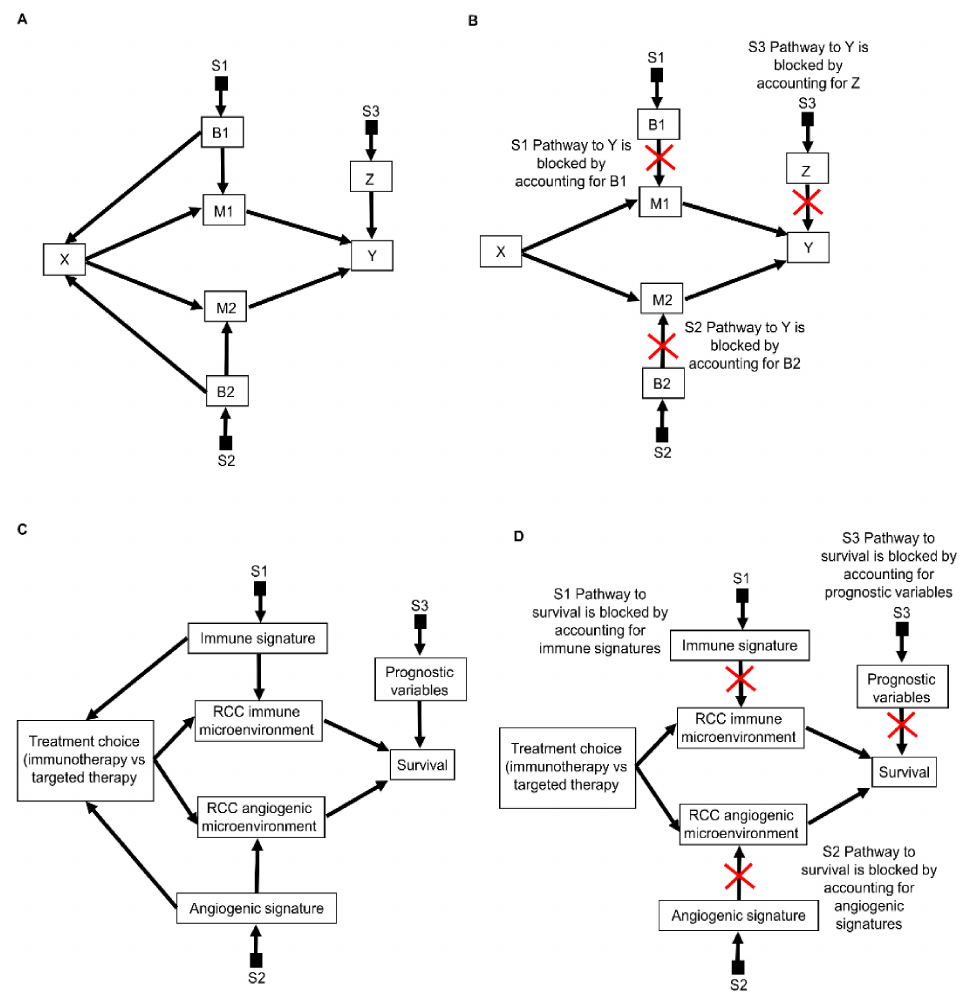
Figure 9. Selection diagrams representing more complex scenarios of treatment effect heterogeneity: ( A ) The effect of treatment choice X on the outcome Y is mediated by two mediators, M1 and M2, which are influenced by biomarkers B1 and B2, respectively. Prognostic variables Z also independently influence the outcome Y. B1 and B2 also influence the treatment choice X. Patient populations may differ in B1 (denoted by S1), B2 (denoted by S2) and in Z (denoted by S3); ( B ) The same selection diagram modified to illustrate the considerations behind the S-admissibility criterion licensing the transportation of knowledge toward the population of patients seen in the clinic. S-admissibility states that once all arrows pointing to the treatment variable X are removed, we need to covariate weight for all variables needed to block all causal pathways that transmit effects from each selection node S toward the outcome Y. In this example, covariate weighting for B1, B2, and Z, respectively, blocks the pathways (as indicated by the red crossmarks) from S1 to Y, S2 to Y, and S3 to Y; ( C ) Corresponding